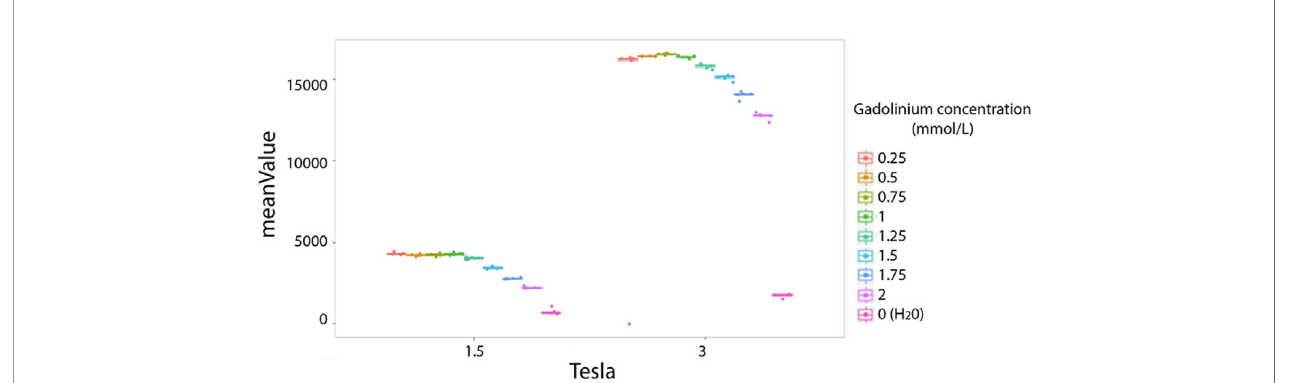
FIGURE 3 | Difference of phantoms textures features values at 1.5 and 3T. Example of the mean value. Each colored dot groups shows the mean value calculated from repeated phantom MRI acquisition (one dot per MRI acquisition) in different homogeneous tubes with different concentration of Gadolinium chelate (on color per tube), respectively at 1.5 and 3T.